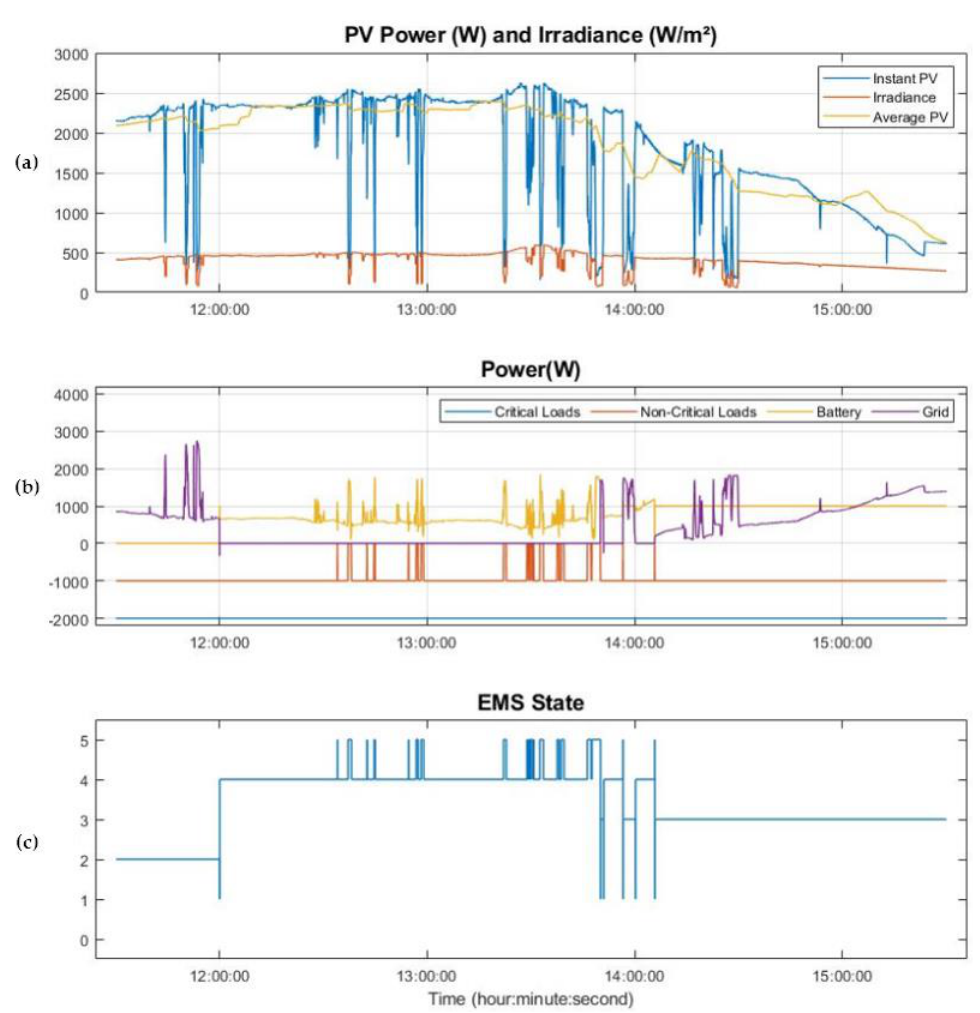
Figure 16. Zoom of use case in the tariff change from OT to PT. ( a ) Instant Power PV production, Average power PV over the last 15 min and irradiance; ( b ) power consumed by critical and non-critical loads, power consumed and delivered by the batteries and power delivered by the grid; ( c ) EMS states.